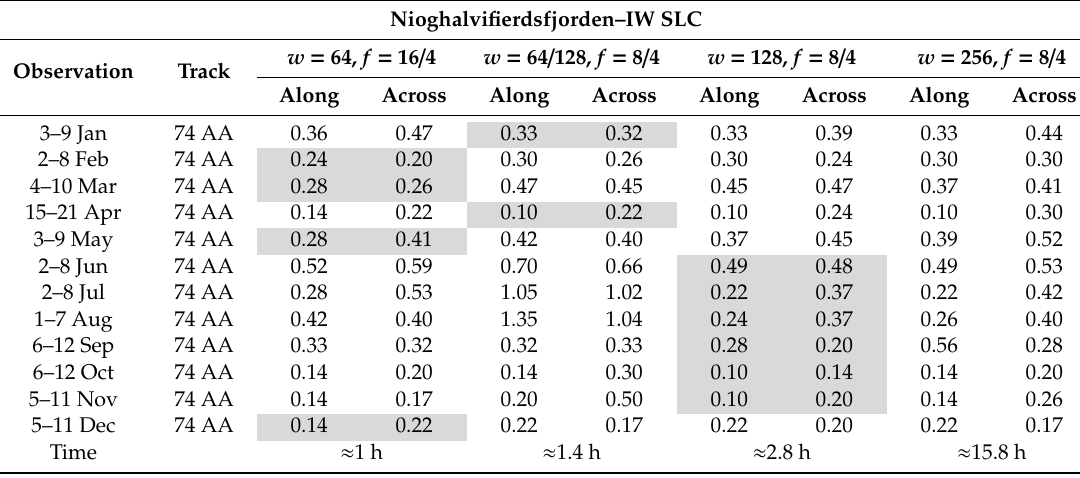
Table 6. NI, IW SLC product class experiments, RMSE (expressed in m / day) with respect to available literature data measured along selected along / across flow transects.